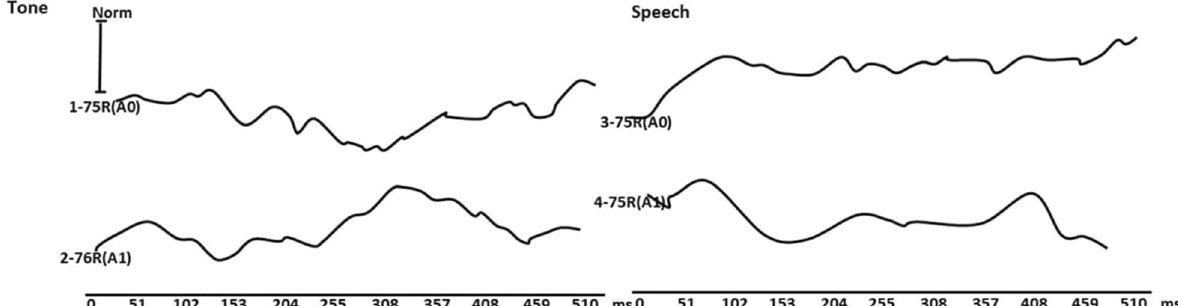
Fig. 1 Traces of standard, deviant and MMN response using tone and speech stimuli of one of the controls